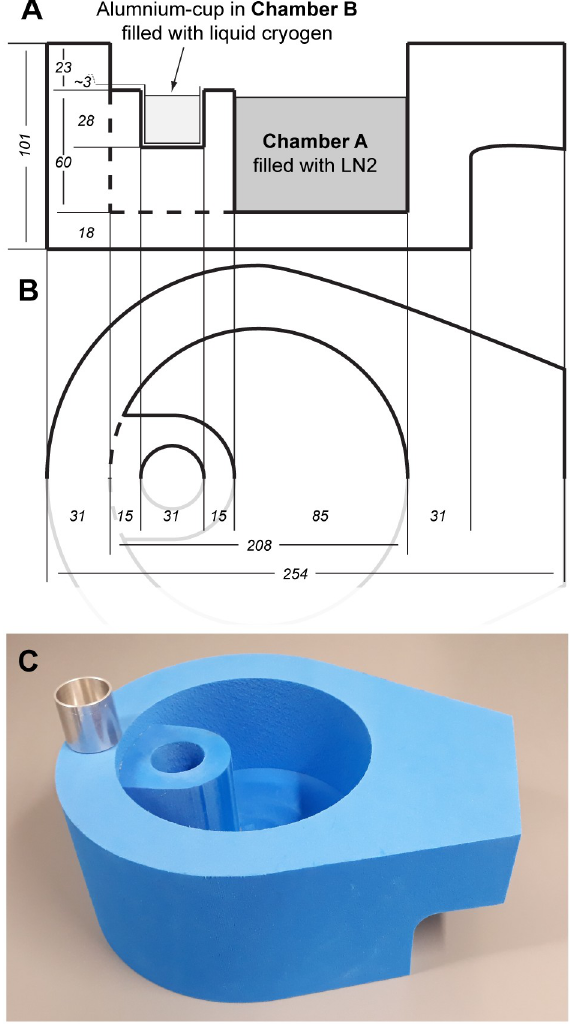
Fig 1. Double-chambered device for flash-cooling macromolecular crystals in different liquid cryogens. ( A and B ) Detailed plan of the crystal flash-cooling double-chambered device as viewed from the side ( A ) and the top ( B ). Dimensions are indicated in mm ( italic numbers ). ( C ) Image of the double-chambered device with the aluminum cup placed on top of the